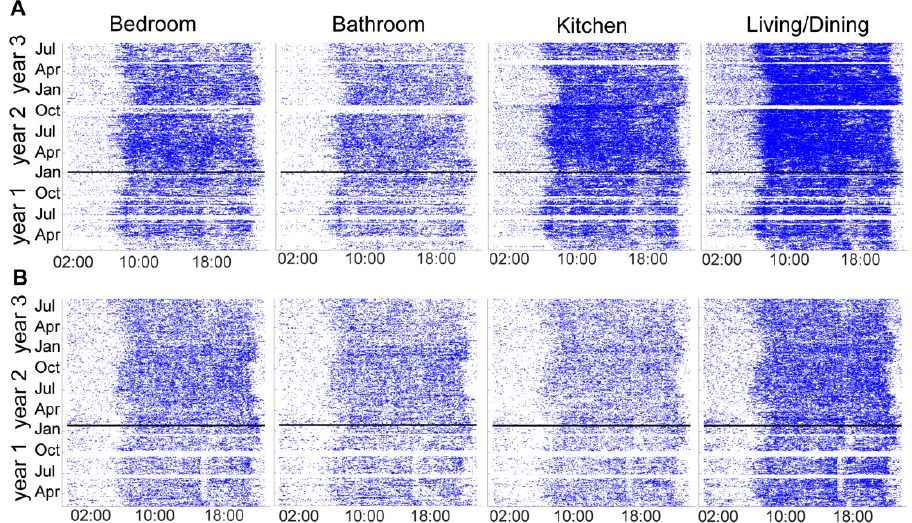
Figure 4. Passive infrared (PIR) motion sensors located in participants’ main living spaces (primary bedroom, primary bathroom, kitchen, and living/dining room) illustrating movement within these rooms across time. ( A ) Room sensor firings in home 1286. ( B ) Room sensor firings in home 1422. The horizontal line indicates when the lights were installed in each home.